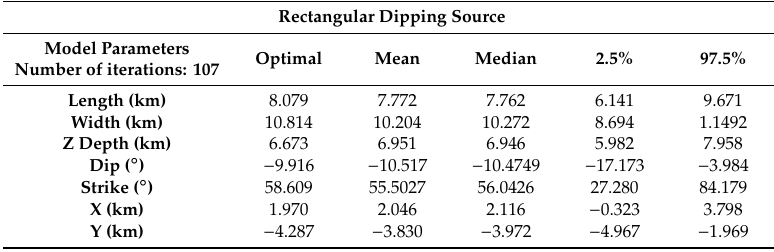
Table A2. Inversion results for the model of a rectangular dipping source. Dip: angle with respect to horizontal (0 ◦ = horizontal; − 90 ◦ or 90 ◦ = vertical); Strike: angle of horizontal edge with respect to North (0 ◦ / 360 ◦ = N; 90 ◦ = E; 180 ◦ = S; 270 ◦ = W); The coordinates X and Y have the coordinate system centered in the geographic position ( − 70.42 ◦ − 36.62 ◦ ); Z: depth of one edge of the rectangular source in meters (positive downwards); Opening: opening of dislocation plane.